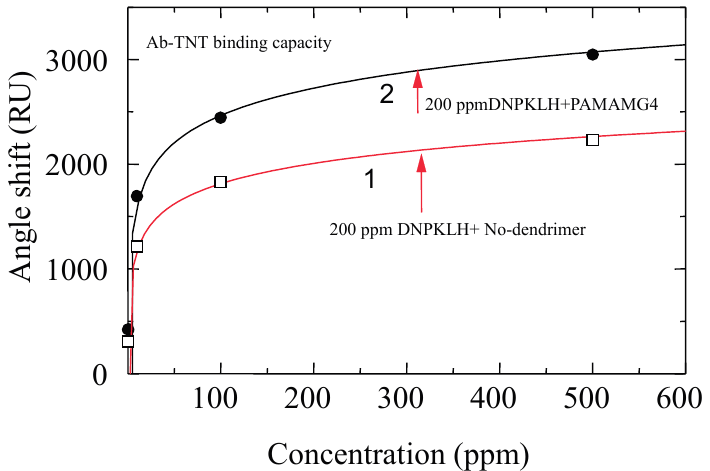
Figure 3. Dependence of resonance angle shift on dendrimer modified and control surfaces with antibody concentration